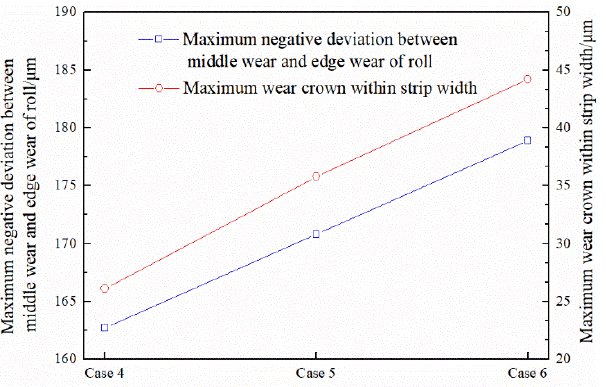
Figure 15. The indexes of roll wear contour under different amplitude at the end of a rolling unit.